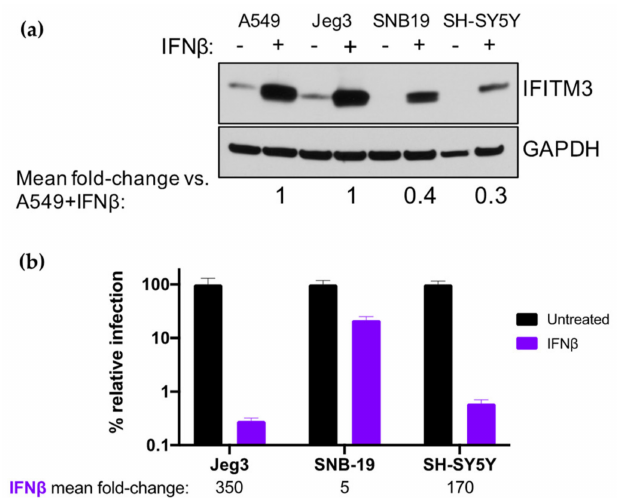
Figure 6. E ff ect of IFN-I pretreatment on ZIKV replication and expression of IFITM3 in Jeg3 and SNB-19 cells. ( a ) Western blot analysis of IFITM3 expression using an anti-IFITM3 antibody in A549, Jeg3, SNB-19, and SH-SY5Y cells. Cells were either untreated or treated with 1000 U / mL IFN α or IFN β for 24 h. For each cell line, the relative induction of IFITM3 expression by IFN β (normalized to GAPDH expression) as compared to A549 cells pretreated with IFN β is noted below the Western blot. ( b ) Infection of Jeg3, SNB-19, and SH-SY5Y cells with ZIKV strain MR 766. The percent relative TCID50 titer measured at 48 hpi is shown. The mean fold-reduction in viral replication in each cell line by pretreatment with IFN β is listed below the graph. Data represent the average of four independent